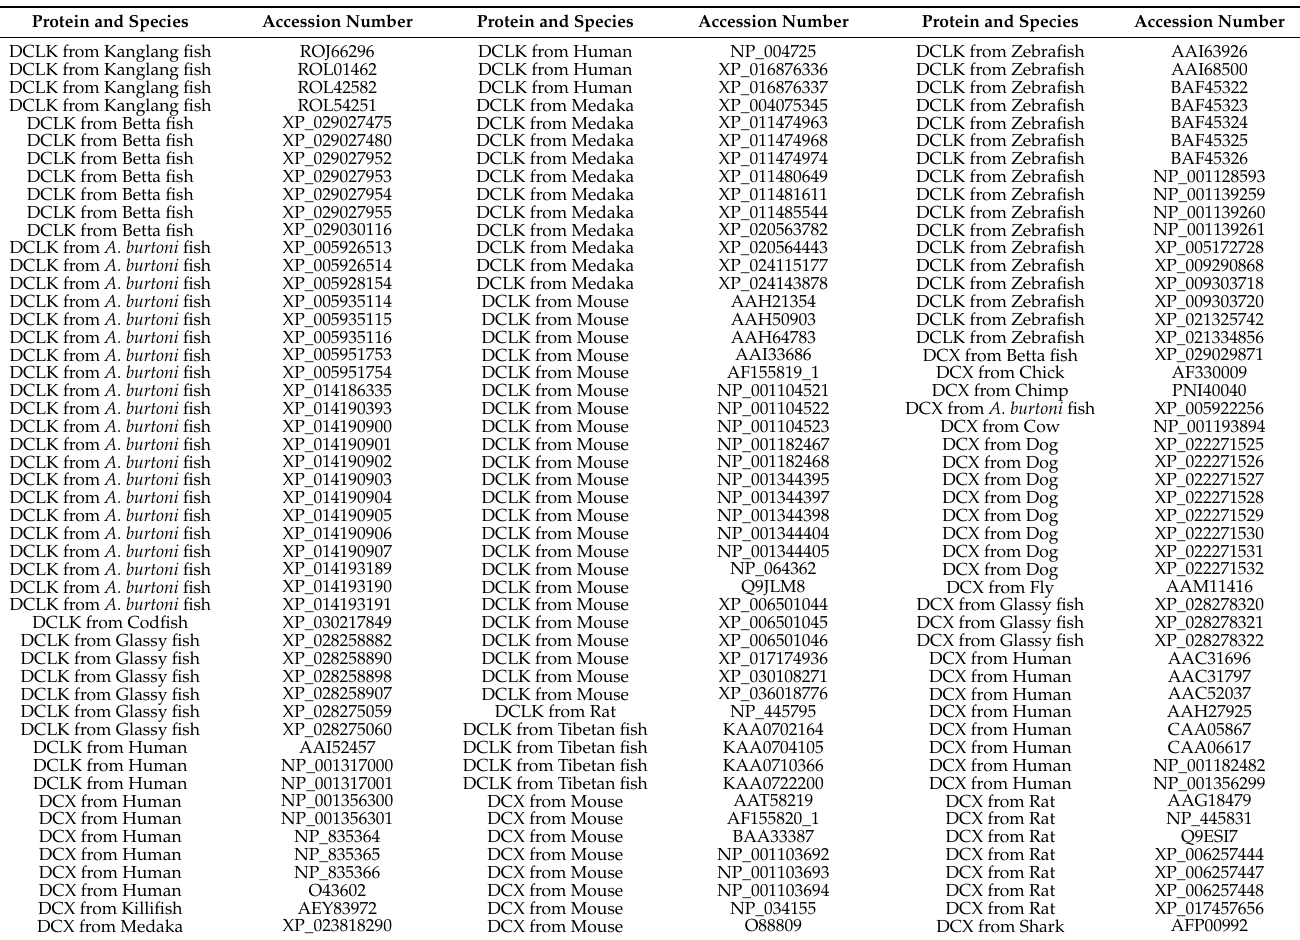
Table 1. Database of 159 amino acidic sequences selected to perform protein alignments. Different species are used to compare DCX and DCLK sequence identity. From this database we also extract DCX1 and DCX2 conserved domains for further sequence